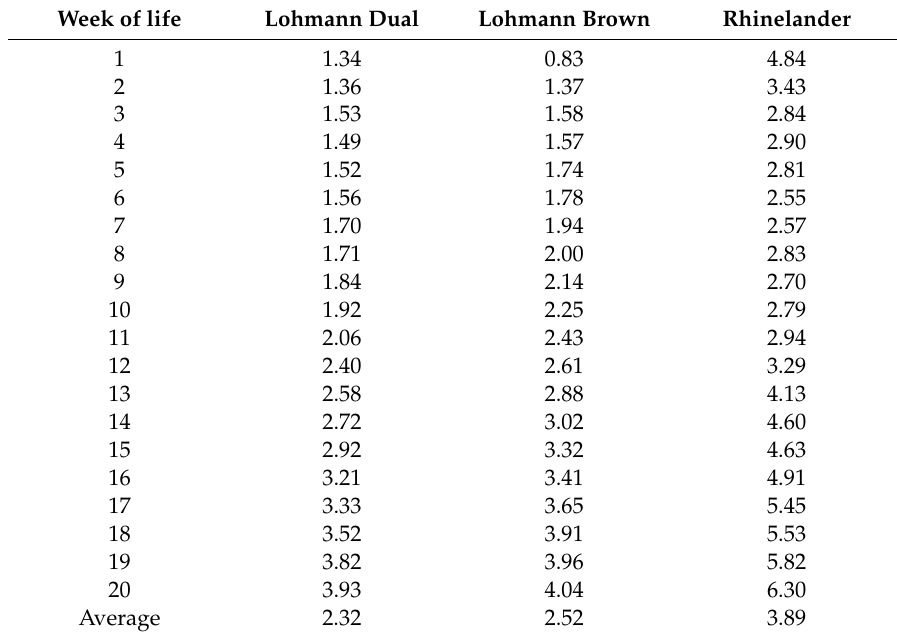
Table 1. Feed conversion ratio (FCR, feed expense ([kg bird − 1 ]) / total weight gain [kg bird − 1 ]) as a measure of feed e ffi ciency, given per genotype and week of life, in addition to average FCR per genotype. Measures were taken from unsexed groups until week 10 (indicated by line), when hens were removed from the flock and only 100 cocks / genotype remained.